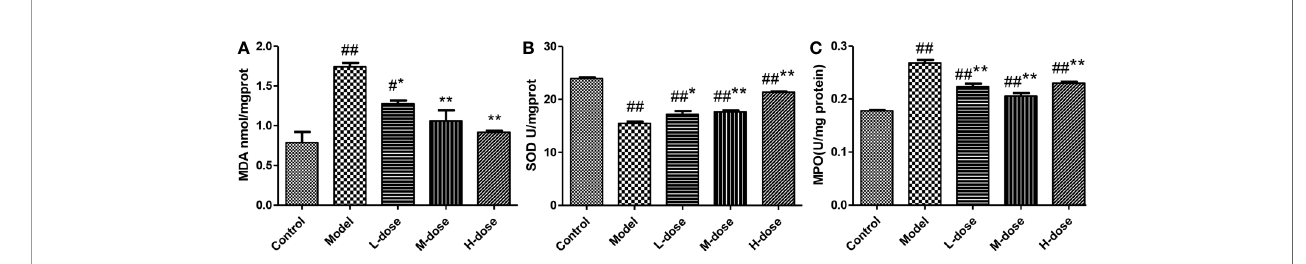
FIGURE 3 | Effects of SLBZS on oxidative stress and MPO in the mouse colon. (A, B) MDA and SOD concentrations in the colon tissue. (C) MPO activity in the colon tissue. The data are shown as the mean ± S.E.M. # P < 0.05, ## P < 0.01 vs. the control group; * P < 0.05, ** P < 0.01 vs. the model group.